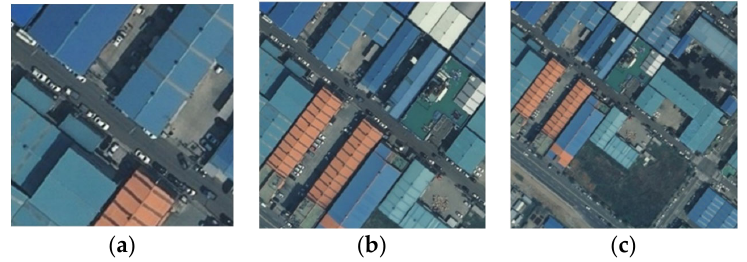
Figure 4. The receptive field of input image sizes: ( a ) 256 × 256, ( b ) 512 × 512, and ( c ) 768 × 768 pix ‐ els.